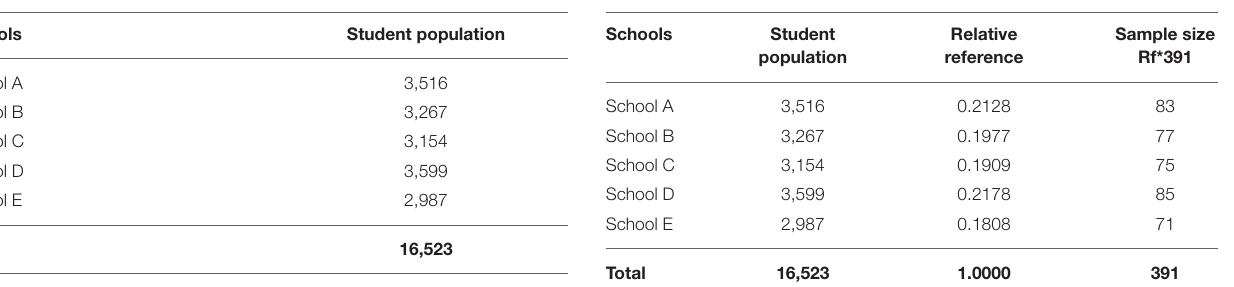
TABLE 1 | Student population of sampled schools. TABLE 2 | Sample size for each student population of sampled